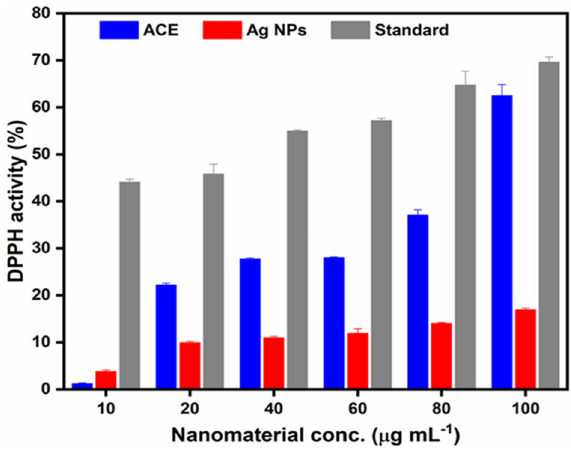
Figure 11. DPPH assay of the ACE and Ag. NPs of Plantago lanceolata